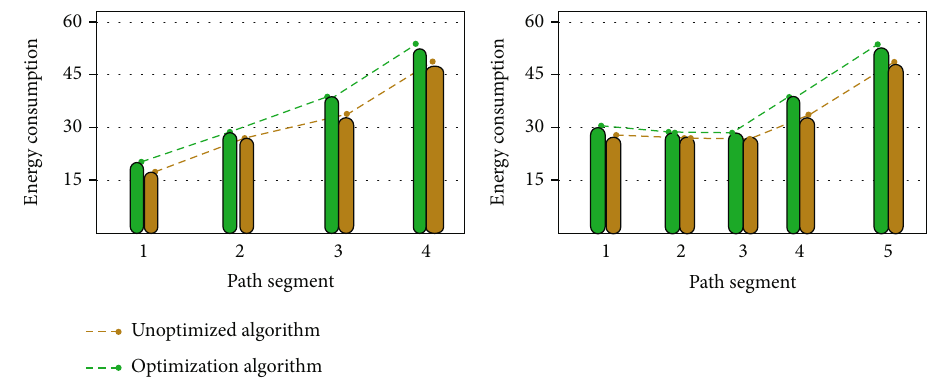
Figure 7: Comparison diagram of fl ight energy consumption during UAV